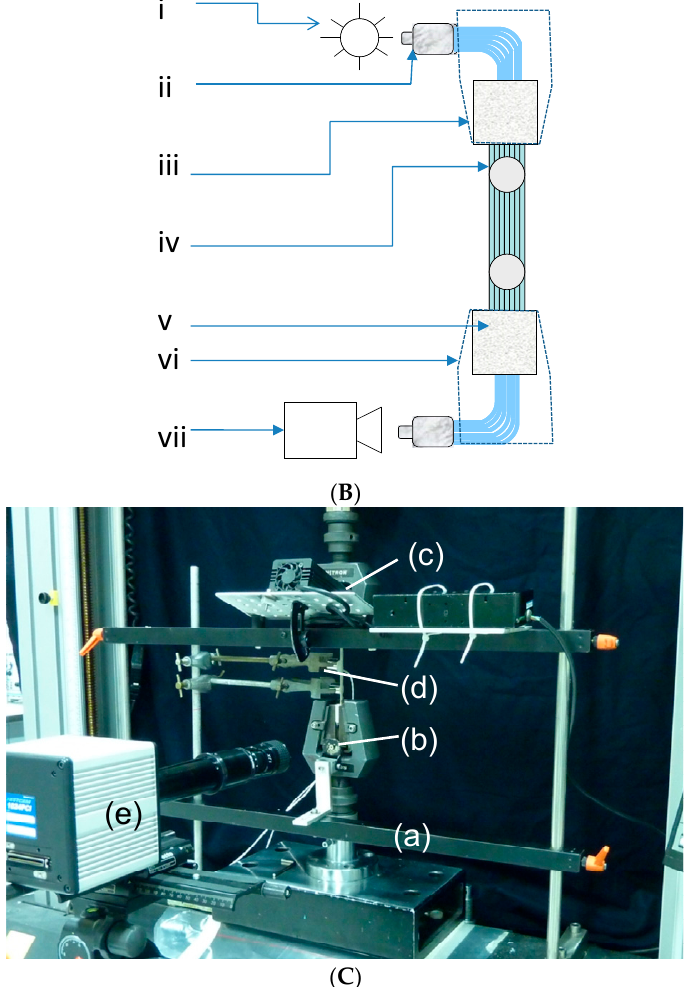
Figure 4. ( A ) Schematic illustration for the tensile test experimental setup: (a) jig that housed the light source and SMA connectors in position; (b) attachment for the SMA connector (high-speed camera-end); (c) platform for the light source; (d) laboratory retort stand for securing the piezoelectric transducers; (e) tensile test specimen; (f) Piezo-electric transducer held in place using a retort stand; (g) detachable base for the jig; (h) moving-end of the Instron tensile test machine; (i) load-cell; (j) white-light source; (k) height adjustment mechanism for the jig; (l) Instron machine columns; and (m) base of the Instron machine (stationary-end); ( B ) Schematic illustration of the location of the light source, grips of the tensile testing machine, the piezo-electric transducers and the high-speed camera. (i) White light (when testing SDOF) or laser source (in conjunction with E-glass); (ii) SMA connector; (iii) Mobile-end of the jaws of the mechanical test machine; (iv) Piezo-electric transducer; (v) Aluminium end-tab; (vi) Stationary-end of the jaws of the mechanical test machine; (vii) High-speed CCD camera; ( C ) Photograph of the tensile test setup: (a) Tensile test fixture; (b) Attachment for the SMA connector (camera-end); (c) Attachment for the white light or laser-light source; (d) Piezo-electric transducers secured in place using a laboratory retort stand; (e) High-speed camera.